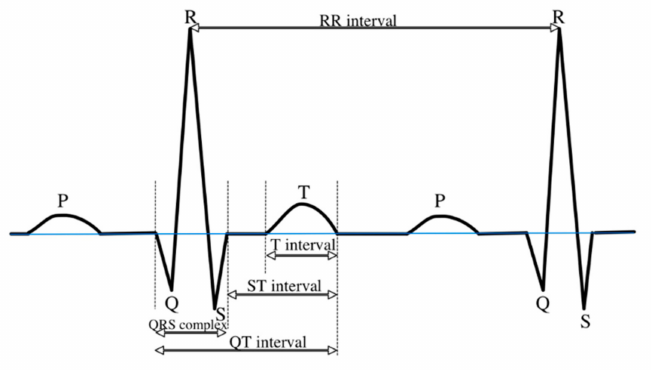
Figure 2. ECG signal features in the V5